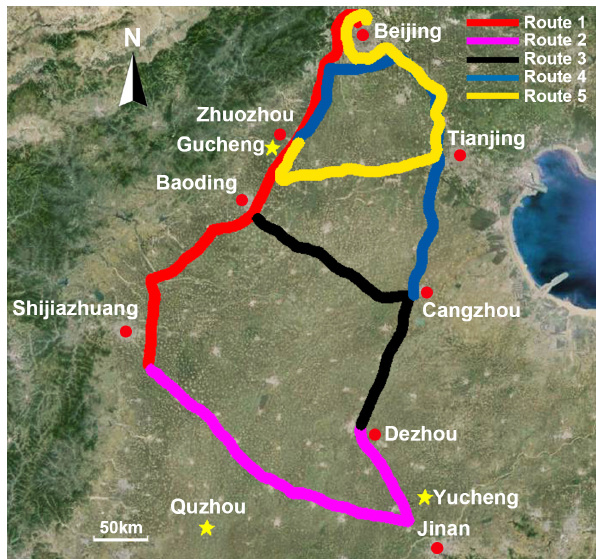
Figure 1. The study area in NCP. The red track shows route 1, from Beijing to Shijiazhuang. The purple track shows route 2, from Shijiazhuang to Dezhou. The black track shows route 3, from Dezhou to Baoding. The blue track shows route 4, from Cangzhou to Zhuozhou. The yellow track shows route 5, from Zhuozhou to Beijing. The red dots on the map present the major cities near the routes. The yellow stars present the monitoring